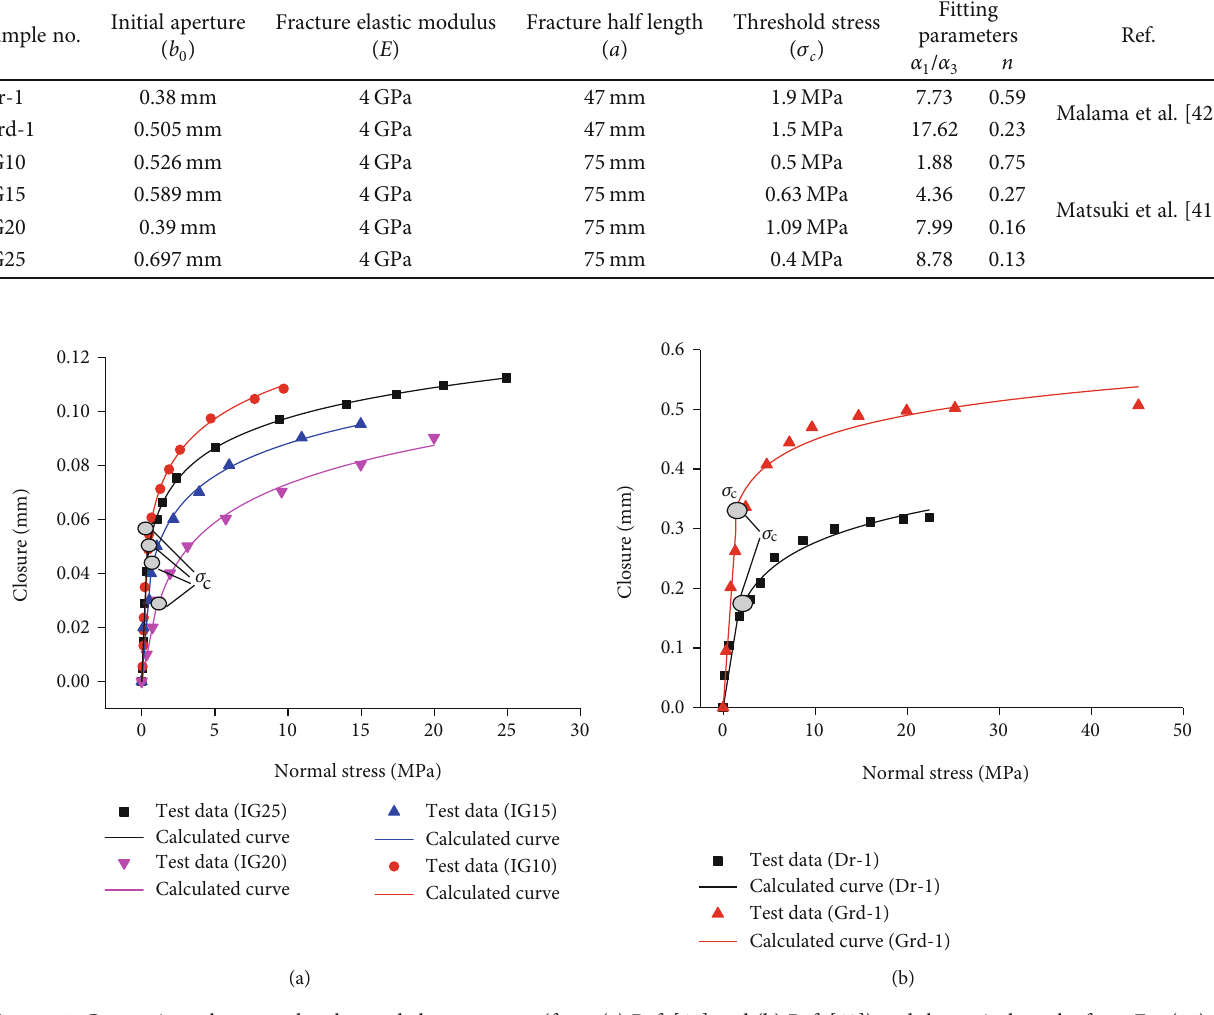
Figure 5: Comparisons between the observed closure curves (from (a) Ref. [41] and (b) Ref. [42]) and theoretical results from Eq. (17). Table 2: Parameter values used for matching the data obtained under compression-shear stress. Normal